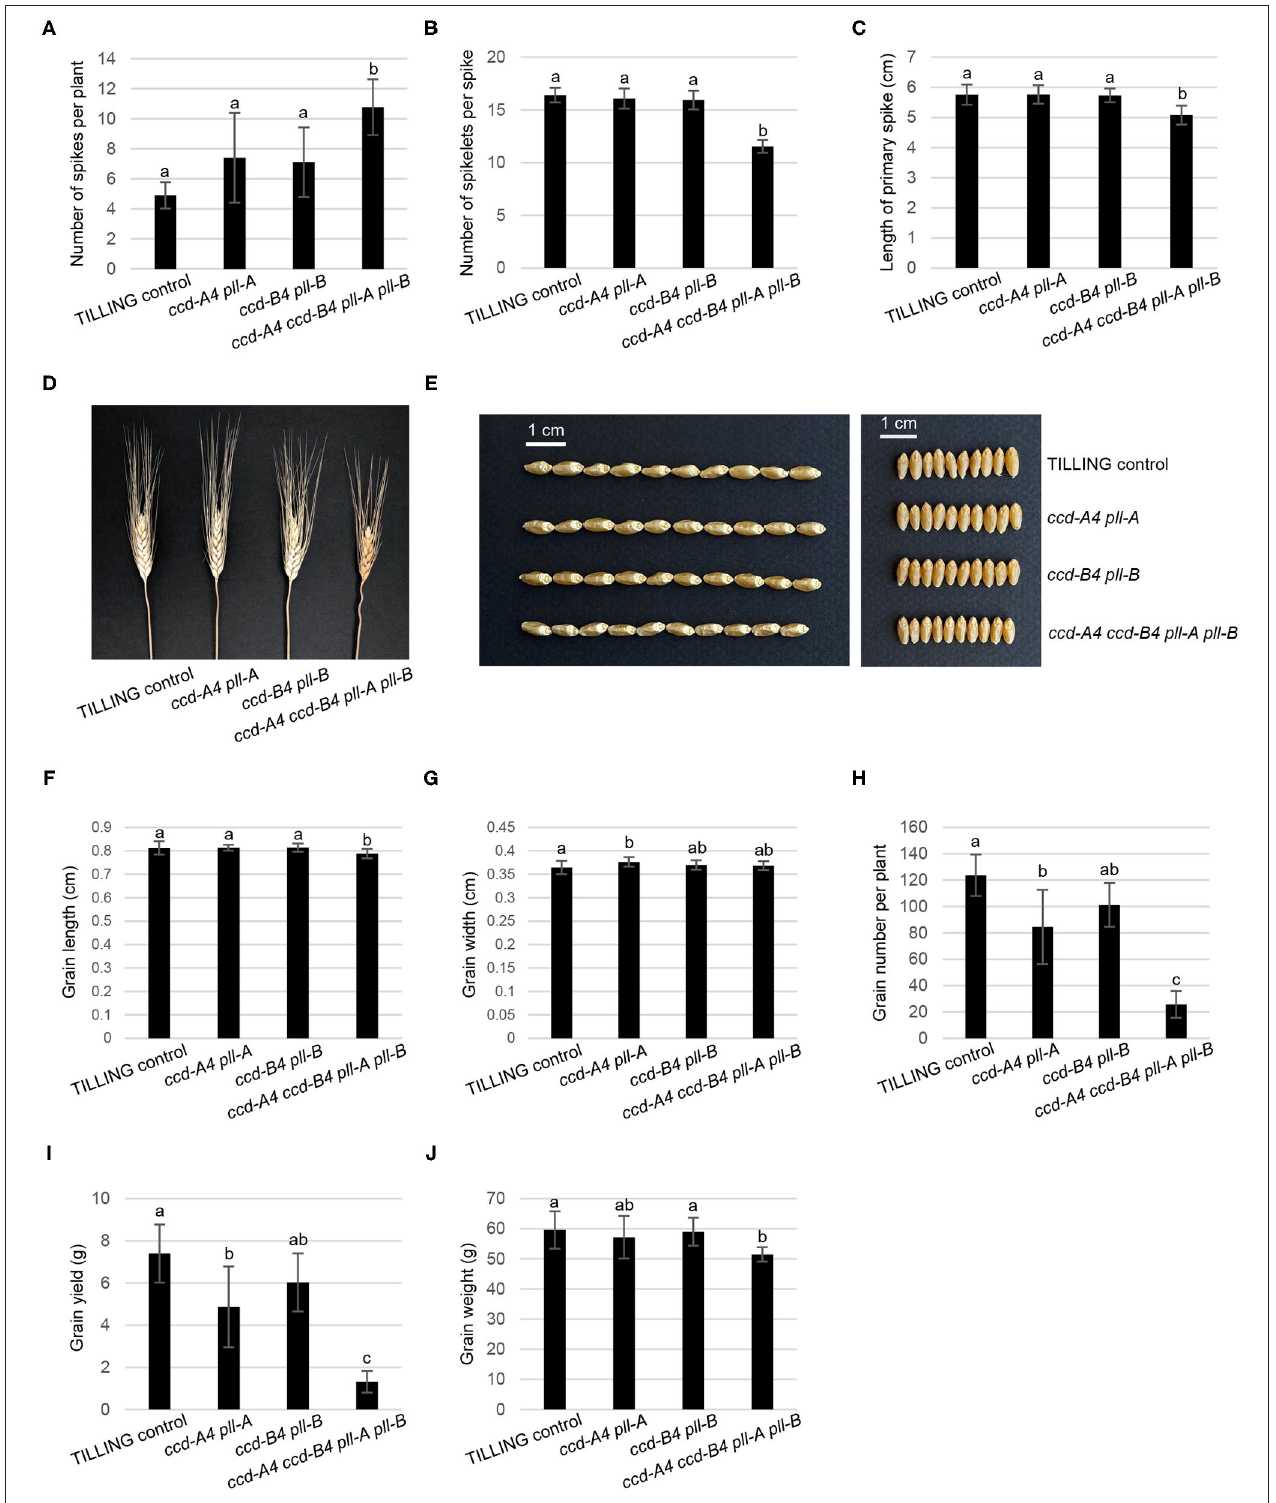
FIGURE 4 | Spike and grain phenotyping of TILLING control and mutant plants. (A) Number of spikes per plant. (B) Number of spikelets per spike. (C) Length of primary spike. (D) Image of TILLING control and mutant spikes. (E) Images of TILLING control and mutant grains. (F) Grain length. (G) Grain width. (H) Grain number per plant. (I) Grain yield. (J) Grain weight. The mean ± standard deviation of 9 biological replicates are shown. Different letters denote significantly different ( P < 0.05) for each spike or grain trait.